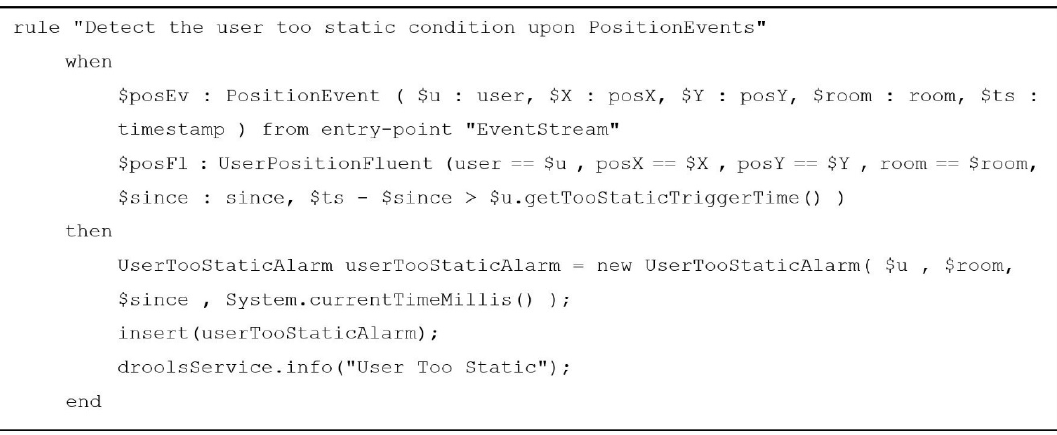
Figure 11. Real and estimated positions for the points of ( a,b ) minimum and ( c,d ) maximum reader- tag distance (mean and point cloud); the active tag is positioned on the chest of the user.